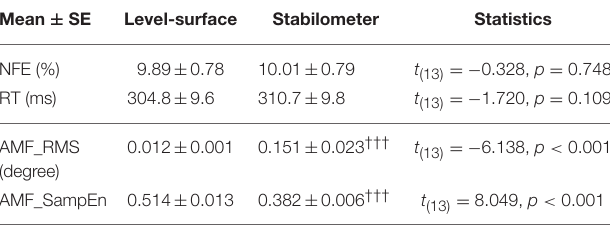
TABLE 1 | Means and standard errors of force-matching and postural variables for the concurrent force-matching and postural tasks in the level-surface and stabilometer